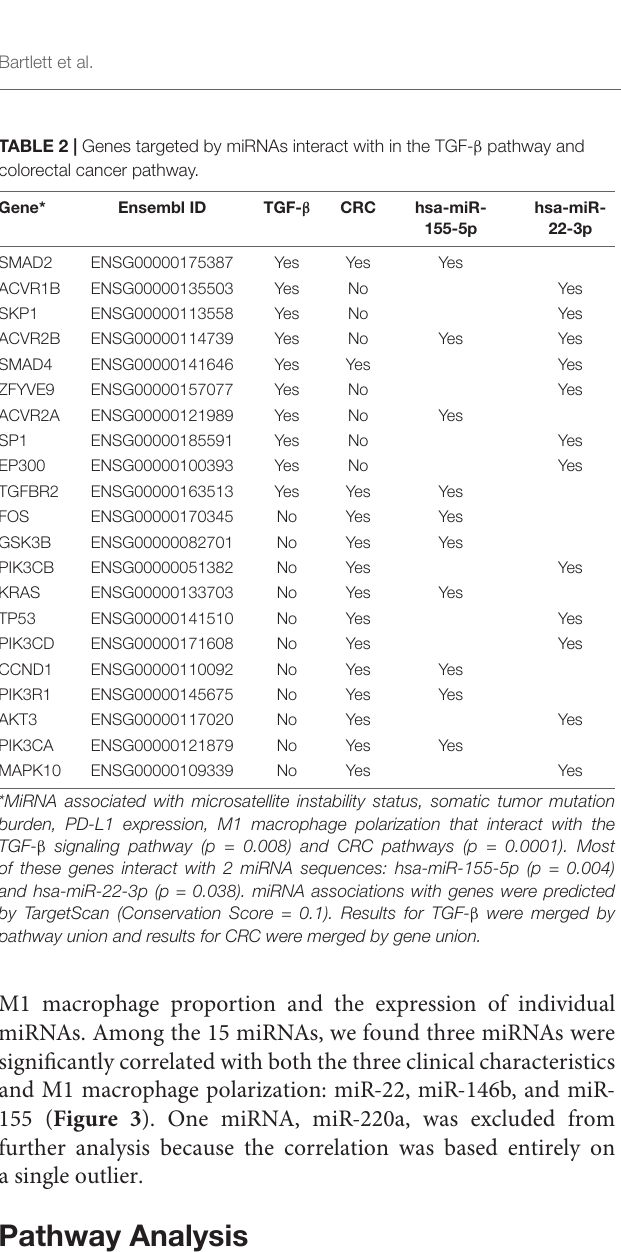
TABLE 2 | Genes targeted by miRNAs interact with in the TGF- β pathway and colorectal cancer pathway. Gene* TGF- β